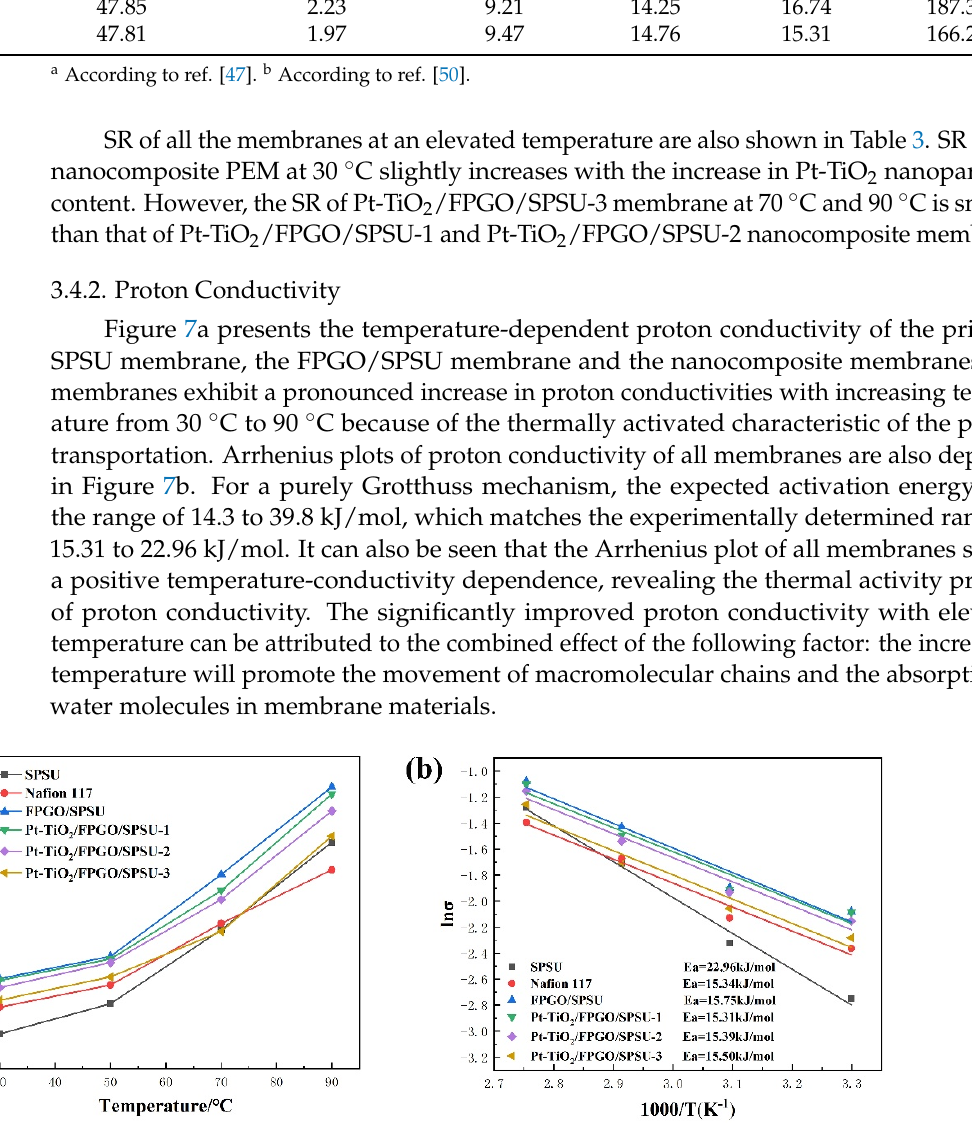
Figure 7. The temperature-dependent proton conductivity ( a ) and Arrhenius plots of proton conductivity ( b ) for all the membranes. (The data of Nafion 117 in Figure 7 are from ref. [44].)